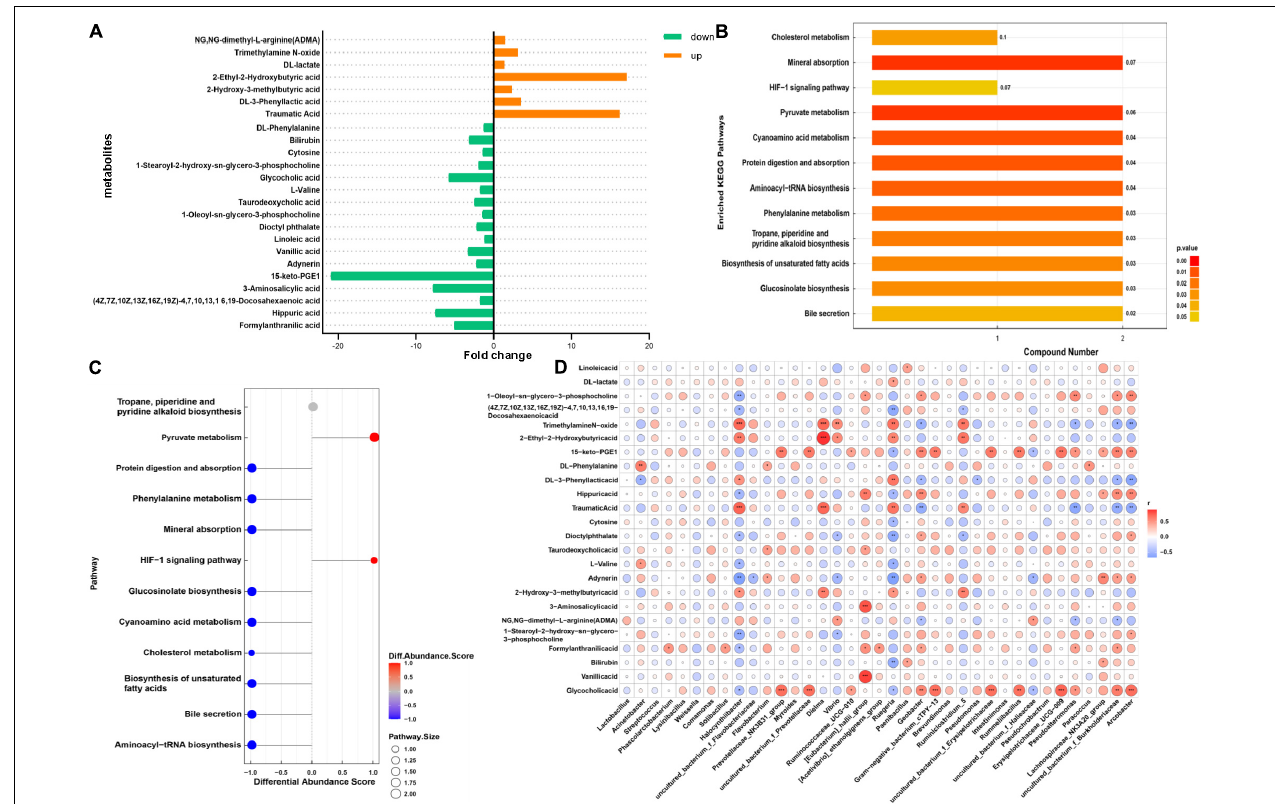
FIGURE 6 | Gut metabolome of diarrheic and healthy goat kids. (A) Different metabolites in the two groups, and fold change represents differential expression multiple. (B) KEGG enrichment pathway diagram, the vertical axis represents each KEGG metabolic pathway, and the horizontal axis represents the number of differentially expressed metabolites contained in each KEGG metabolic pathway. Color represents the P -value of enrichment analysis. (C) Differential abundance score plot of differential metabolic pathways. The DA score is the overall total change of all metabolites in the metabolic pathway. (D) Heatmap of correlations between differential metabolites and bacterial genus (Spearman’s rank correlations). The darker the color, the greater the absolute value of r. * Means 0.01 < P < 0.05, ** means 0.001 < P < 0.01, and *** means P <